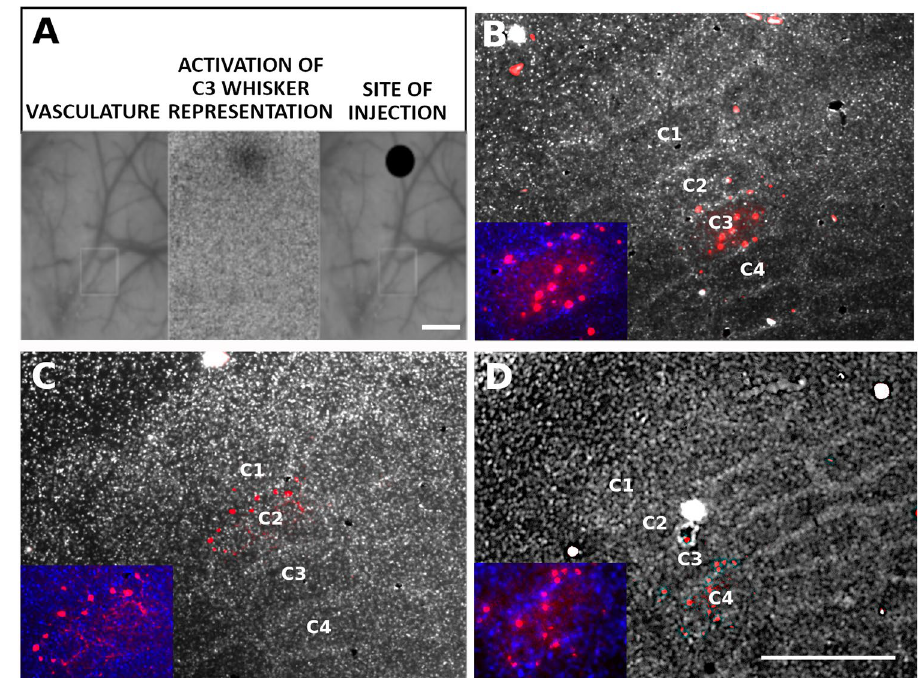
Figure 2. Single barrel nanoinjection under optical imaging of intrinsic signals. ( A ) Images were taken during optical recordings of the activated barrel cortex. Left: an image of the brain vasculature illuminated with green light. Middle: a functional image of the activated C3 representation obtained during C3 whisker stimulation, acquired with orange light illumination. Right: site of injection determined by the superimposition of the two previous images. Scale bar = 500 µm. ( B–D ) Tangential sections of the barrel cortex layer 4 present SOM-IN transduction with DREADDs (red cells) selectively in the representation of C3, C2, or C4 whisker, respectively. Scale bar = 500